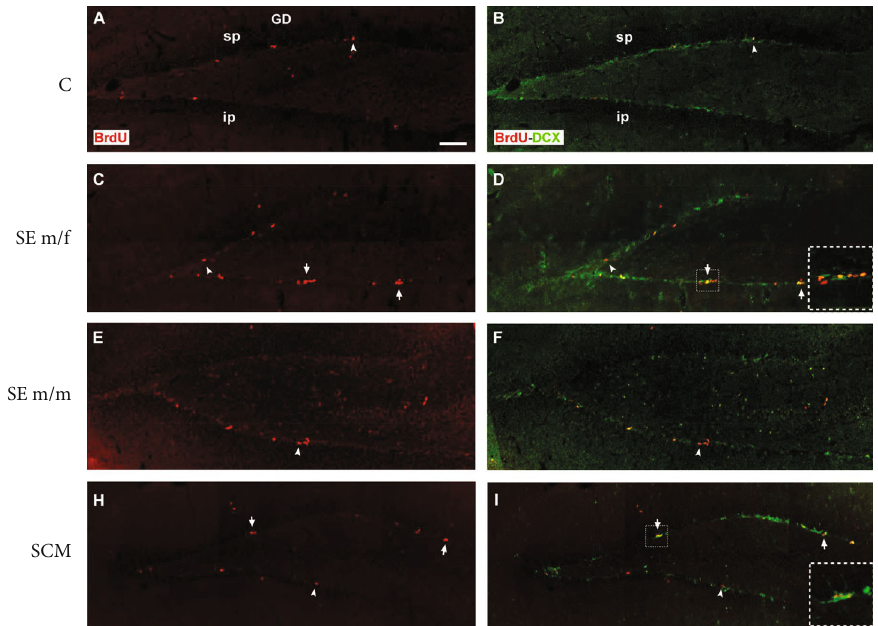
Figure 7: Representative photomicrographs of immunolabeling for BrdU (red; (a, c, e, h)) and double immunolabeling for BrdU/DCX (red/green; (b, d, f, i)) from the DG of the control (C), social exposure to a female (SE m/f), social exposure to a male (SE m/m), and social cohabitation with mating (SCM) animals. White arrowheads point to single BrdU-positive cells, and white arrows indicate clusters of BrdU/DCX-positive cells. Scattered squares: enlargements of the inserts at 20x, which show clustering of proliferating neuroblasts observed in the DG from the SE m/f and SCM voles. sp: suprapyramidal blade; ip: infrapyramidal blade. 20x. Scale bar: 100 μ